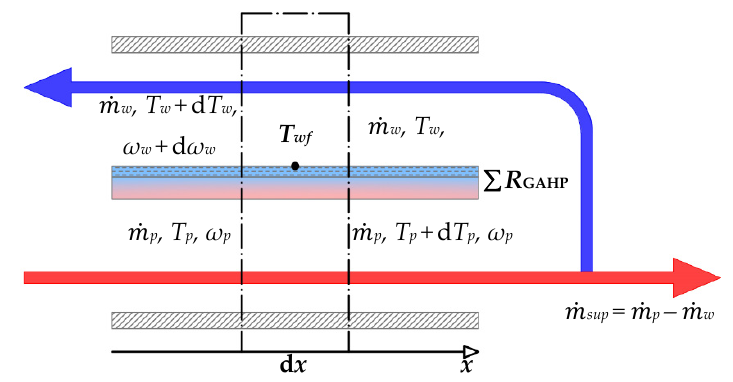
Figure 2. Computational element applied for development of the mathematical model.